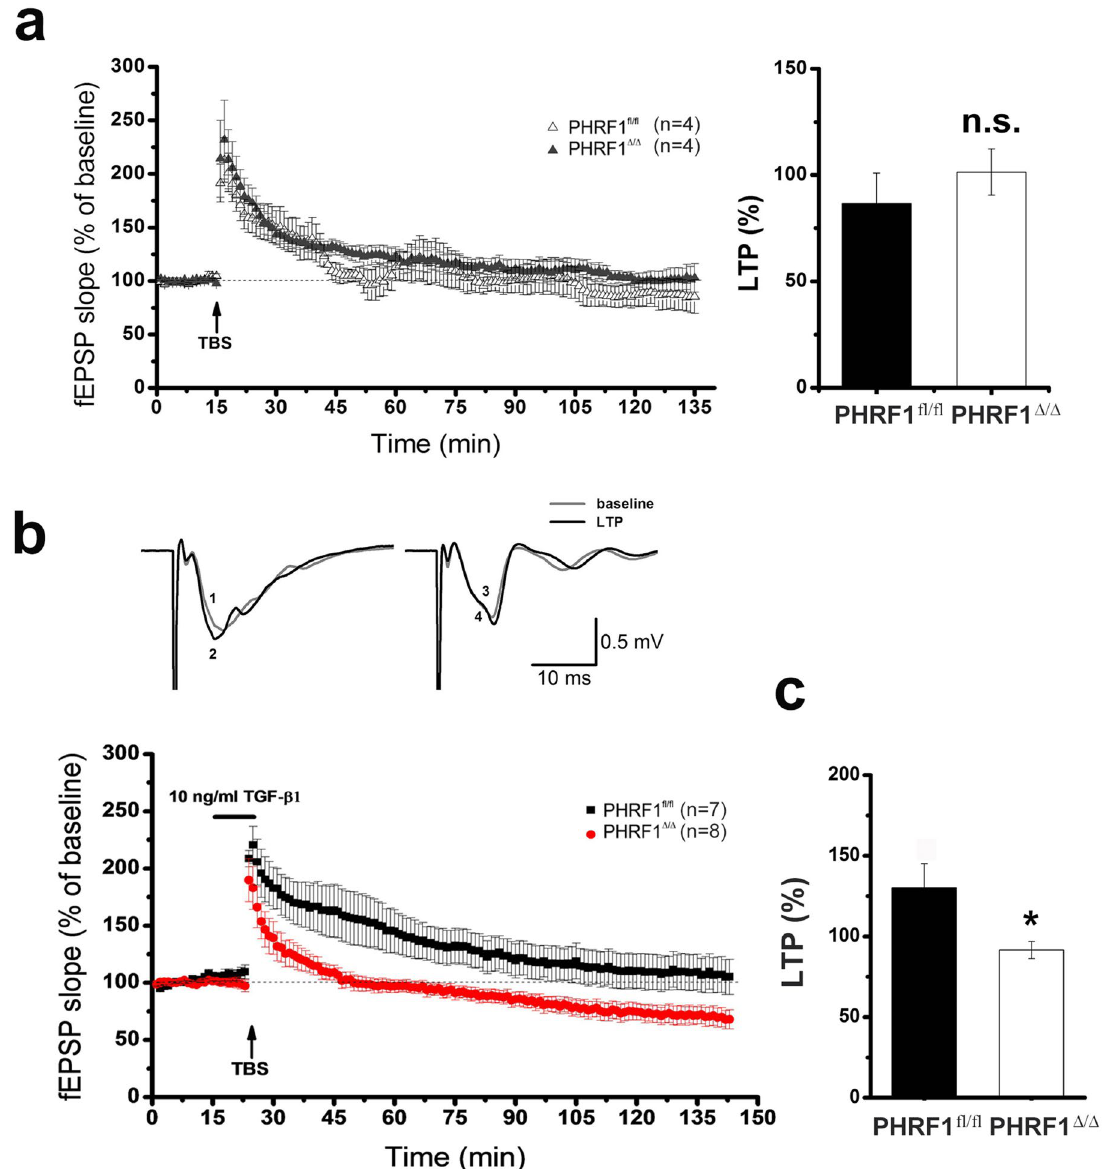
Figure 5. Theta burst stimulation (TBS) induced synaptic changes in the hippocampal slices. The extracellular field-EPSP (fEPSP) was recorded in hippocampal slices following the stimulation of the Schaffer collateral pathway. ( a ) An arrow indicates the start of theta burst stimulation (TBS). Note that there is no statistical difference (n.s.) between genotypes. ( b ) The hippocampal slices were incubated with TGF-β1 (10 ng/ml) for 15 min before the application of TBS (arrow). The black and red dots represent averaged points of fEPSP slope from PHRF1 fl/fl and PHRF1 Δ/Δ mice, respectively (n = 7 slices from 4 PHRF1 fl/fl mice; n = 8 slices from 4 PHRF1 Δ/Δ mice). Upper panel shows the representative tracings before (grey) and after (black) TBS of PHRF1 fl/fl and PHRF1 Δ/Δ mice. ( c ) At 60 min after TBS, the mean fEPSP values were analyzed by one-way ANOVA. Data are mean ± SEM. * p <